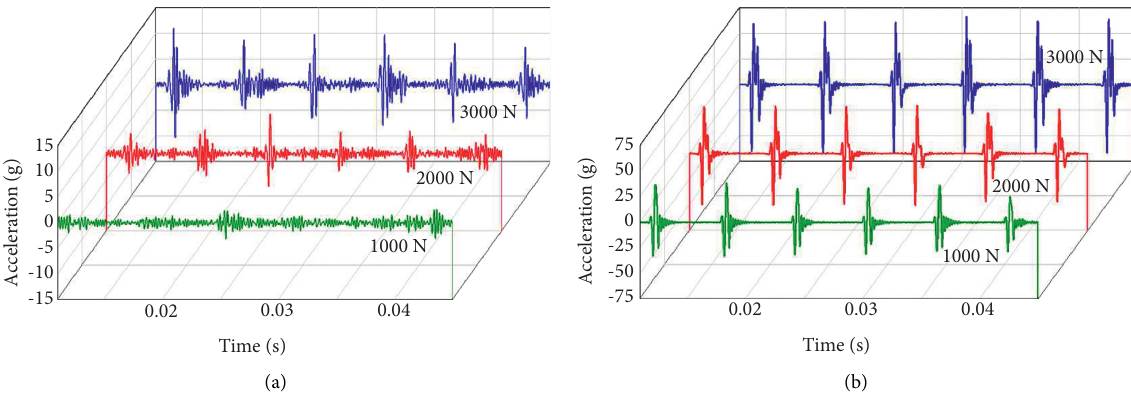
Figure 11: Acceleration signals under different loads at different points: (a) the measurement point #8 and (b) the defect point